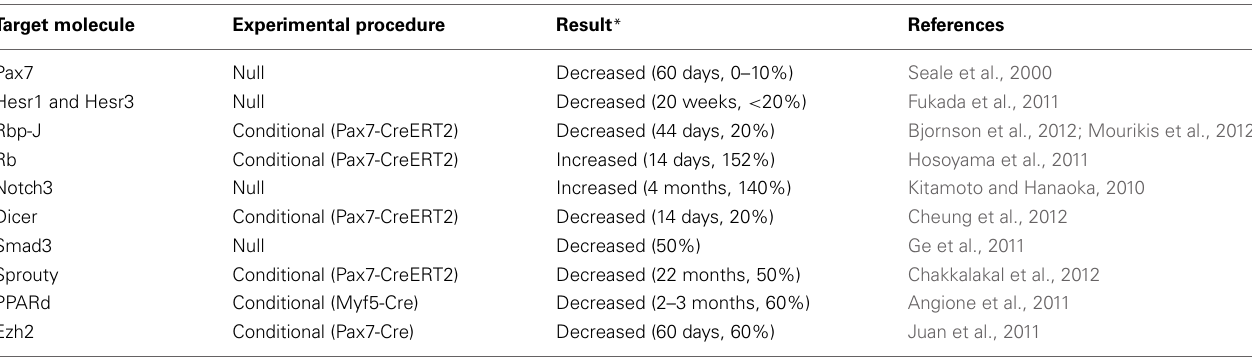
Table 2 | Genes known to control satellite cell number in vivo